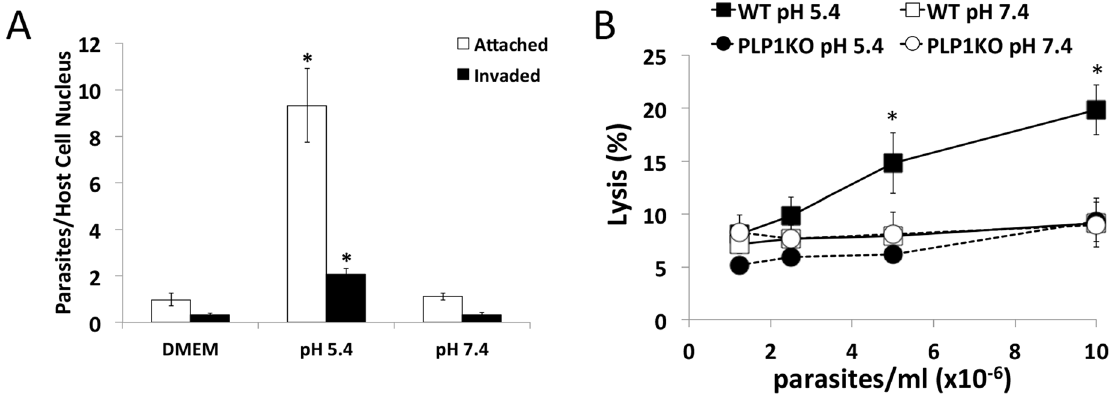
Figure 6. Acidic pH increases invasion but results in host cell damage. (A) Low pH promotes parasite attachment and invasion. HFF cells were pulse invaded for 2 min with parasites in DMEM, or DMEM-like buffer at pH 5.4 or 7.4. * p , 0.05 vs. DMEM by student’s t -test. Graph indicates the average and standard deviation of 3 independent experiments. (B) PLP1- and pH-dependent damage to host cells. HFF cells were preloaded with calcein-AM and WT and plp1ko parasites were allowed to settle on host cells in Endo buffer, which was subsequently switched to DMEM-like buffer of the indicated pH and incubated at 37 u C for 10 min. Calcein signal in the supernatant was measured by fluorometry. Graph indicates average and standard deviation of triplicate wells and is representative of 3 independent experiments. * p , 0.05 vs. WT pH 7.4 by student’s t -test.